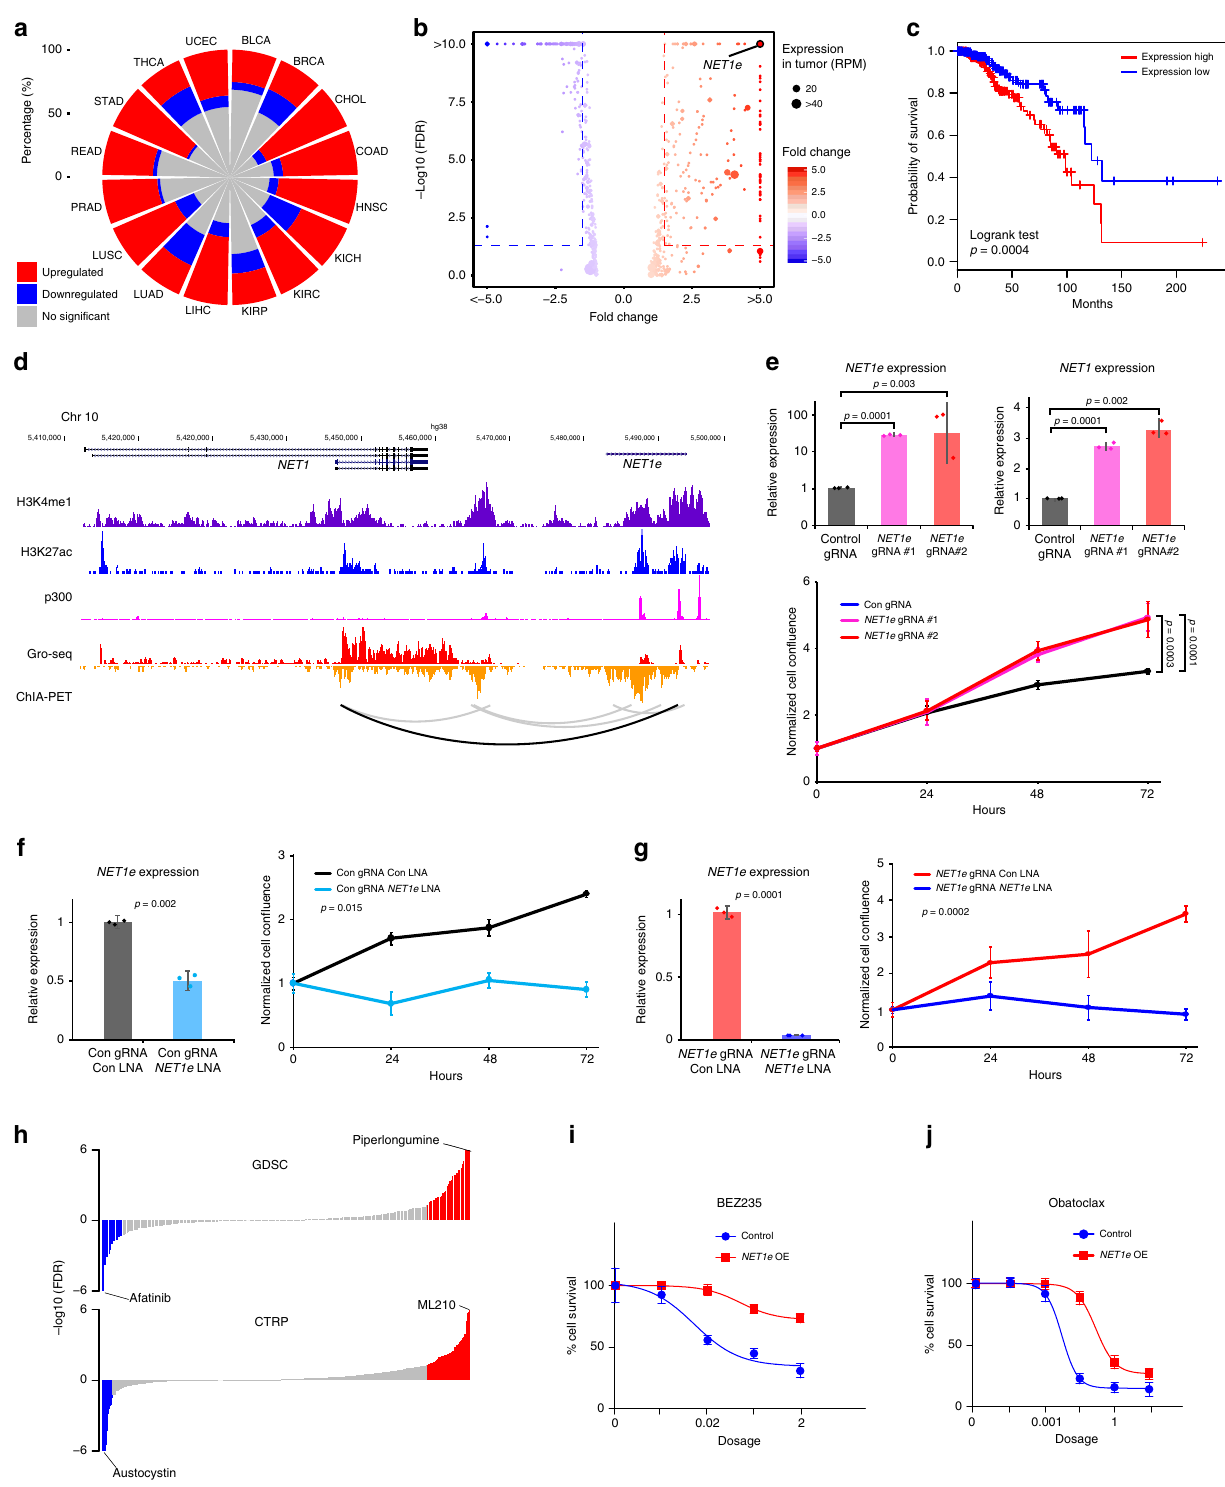
Fig. 5 Functional characterization of NET1e in cancer. a Expression alterations of eRNAs in human cancers. Red, blue and gray, respectively, denote percentage of upregulated, downregulated and no signi fi cant expression of eRNAs in each cancer type. b Differentially expressed eRNAs in BRCA. Scale bar denotes the fold change between tumor and normal samples. c Survival curves for NET1e in BRCA (top quarter in red vs. bottom quarter in blue). d Epigenetic features and expression of NET1e and NET1 region in MCF7. e Overexpression of NET1e in MCF7 and its functional consequences. Overexpression of NET1e by CRISPR/dCas9-SAM (top left) and NET1 (top right), and cell growth assay with overexpression of NET1e in MCF7 (bottom). f Knockdown NET1e by LNA (left) and cell growth assay (right) in MCF7. g Knockdown NET1e by LNA after activation (left) and cell growth assay (right) in MCF7. h NET1e- associated drugs in GDSC and CTRP database. i Response curve of compound BEZ235 in NET1e overexpressed cells and control. j Response curve of compound Obatoclax in NET1e overexpressed cells and control. Error bars in ( e ), ( f ), ( g ), ( i ), and ( j ) indicate mean ±